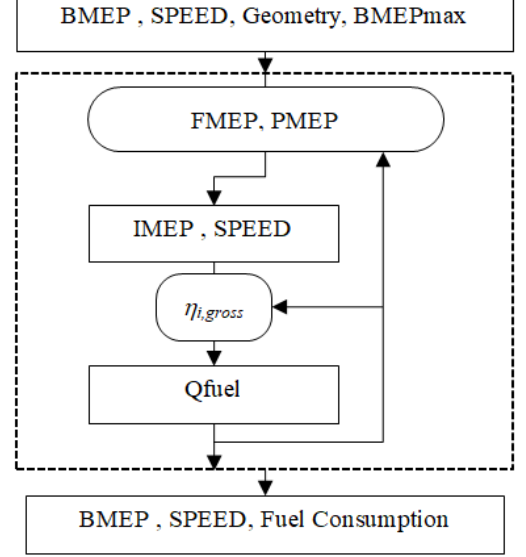
Figure 5. Implicit algorithm applied to compute physical